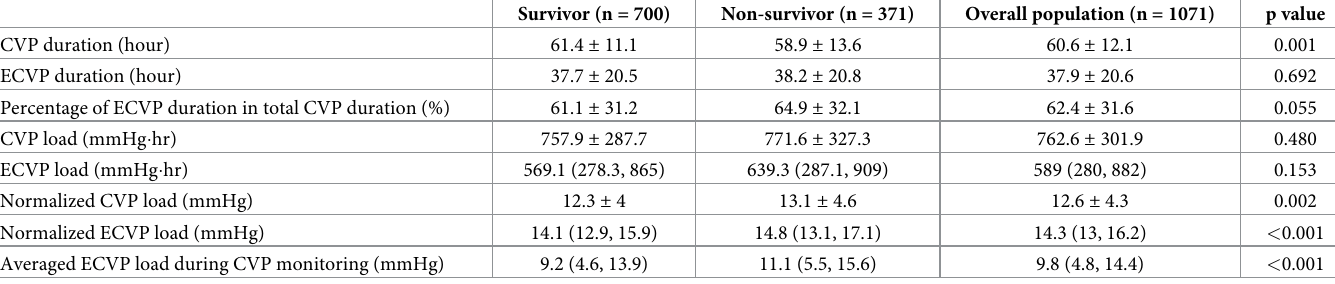
Table 2. Comparisons of the duration and the load of central venous pressure between survivors and non-survivors.